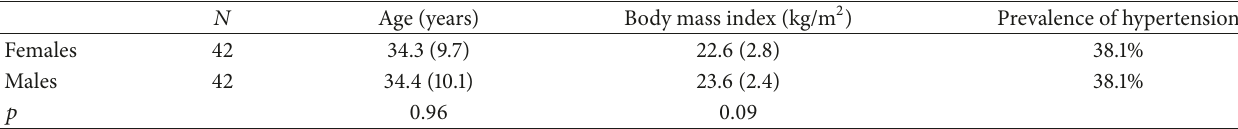
Table 1: General characteristics of participants by